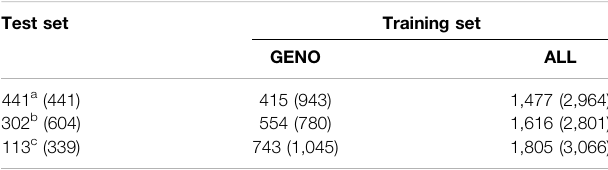
TABLE 4 | Number of animals (number of records) for test and training sets for FY and PY. Test